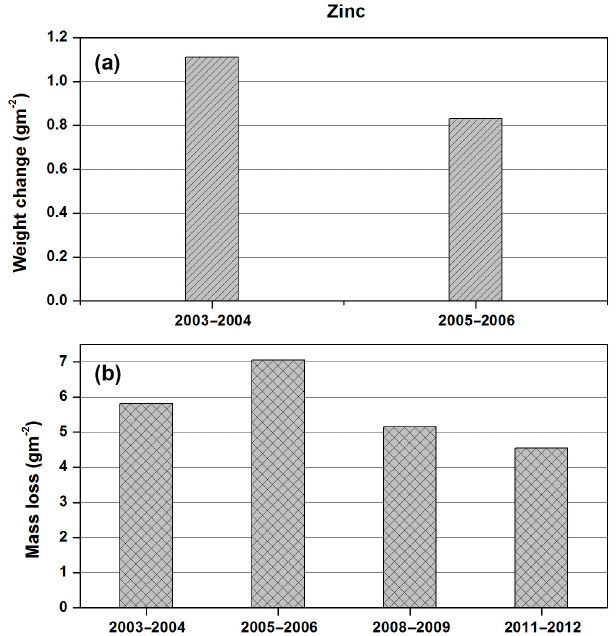
Figure 3. (a) Mean weight change of zinc samples exposed during the periods 2003–2004 and 2005–2006 and (b) mean mass loss of zinc samples exposed during the periods 2003–2004, 2005–2006, 2008–2009 and 2011–2012.